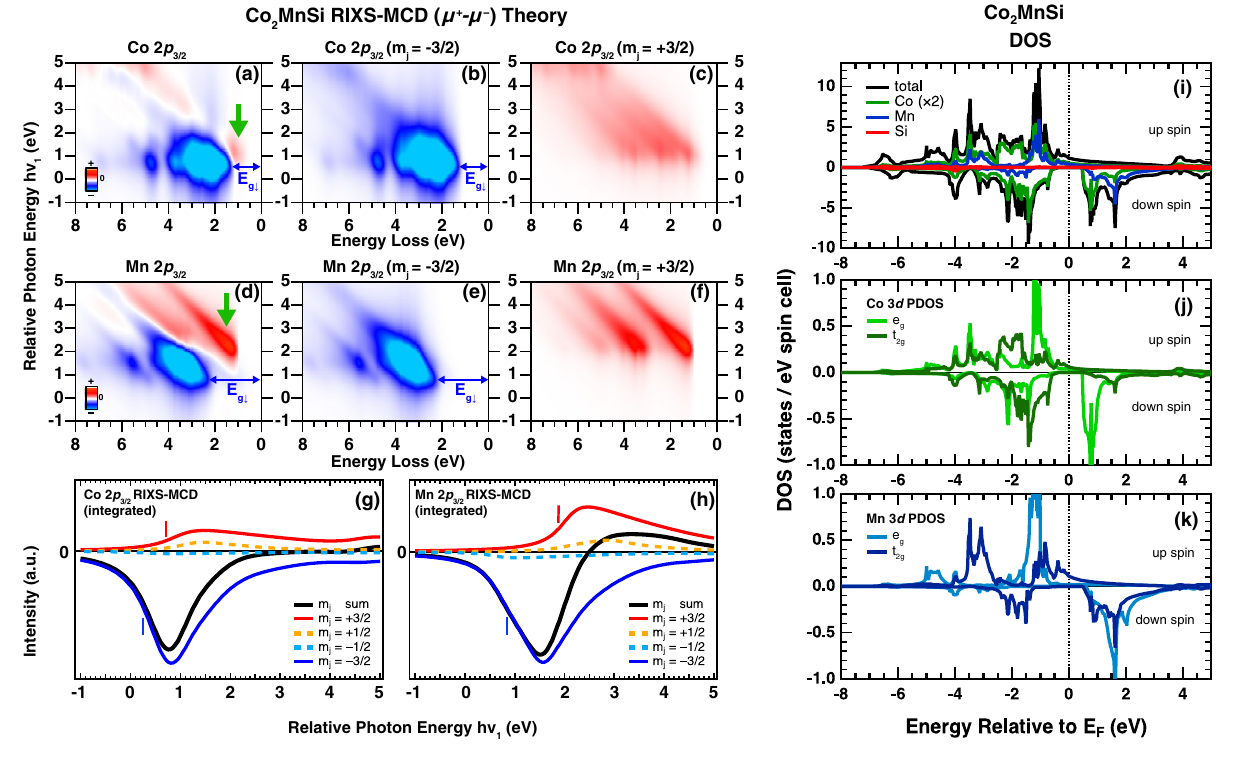
Figure 4. Theoretical RIXS-MCD spectra for Co 2 MnSi at the Co 2 p 3 / 2 edge ( a ). The m j = − 3 / 2 and + 3 / 2 components are shown in ( b , c ). Theoretical RIXS-MCD at the Mn 2 p 3 / 2 edge ( d ) and the m j = ± 3 / 2 components are shown in ( e , f ). The green arrows in ( a , d ) indicate the m j = + 3 / 2 components located in the down-spin gap ( E g ↓ ) of m j = − 3 / 2 components obtained in ( b , e ). The incoming photon energy dependence of the m j resolved MCD intensity integrated over whole loss energies are also shown in ( g , h ) for Co and Mn edges, respectively. The vertical bars indicate the threshold energies of the m j = ± 3 / 2 components. ( i ) the theoretical prediction of the spin-dependent DOS and PDOS of Co, Mn, and Si. ( j , k ) the e g and t 2 g components of the PDOS of Co and Mn,